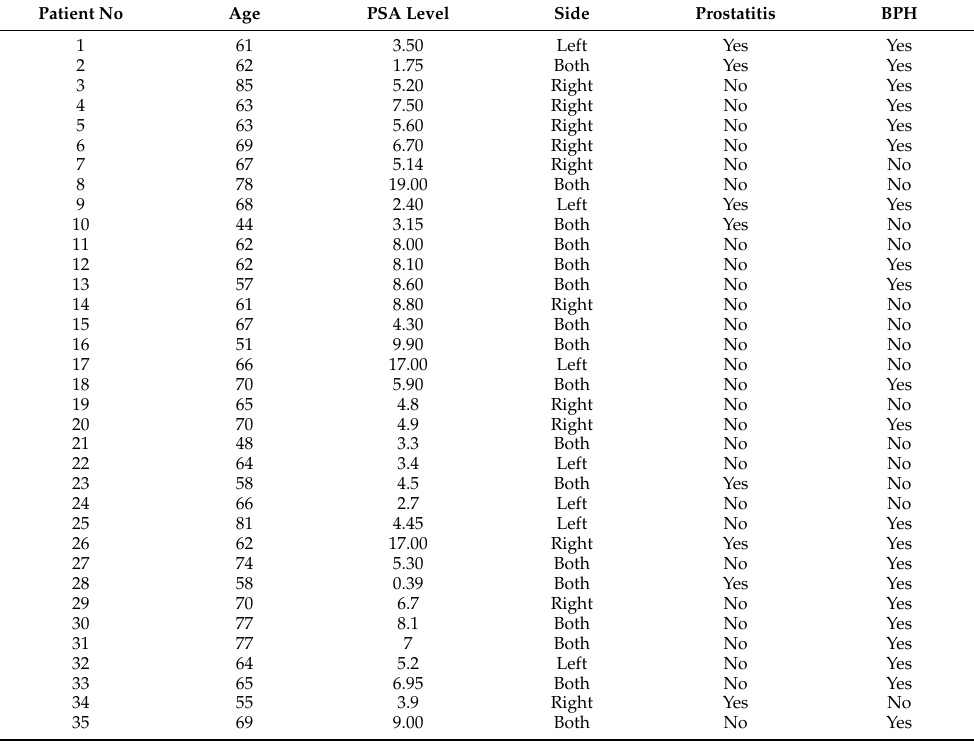
Table A2. Detailed description of the medical parameters of the examined